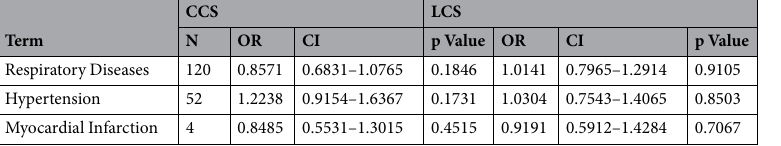
Table 2. Statistics for average number of cigarettes smoked per day for those aged under 35 years. The unit of CCS and LCS is 10 cigarettes per day.